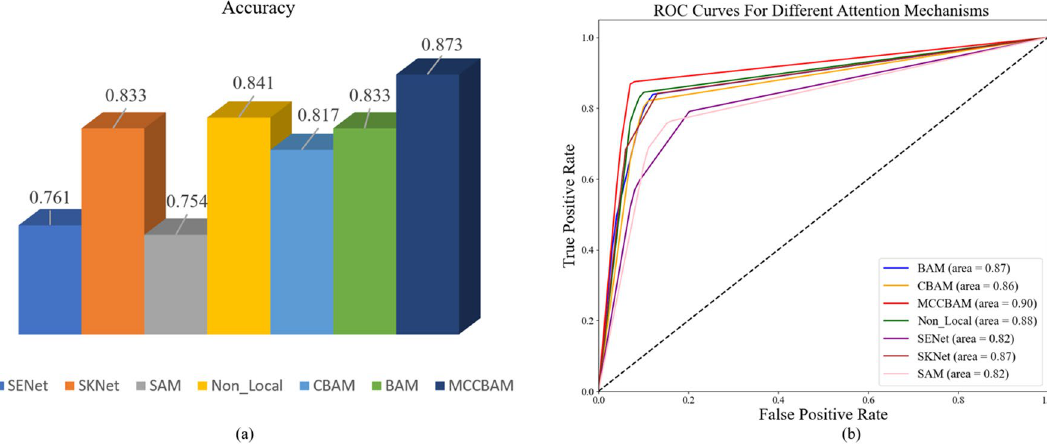
Figure 5. ( a ) Accuracy of VGG16 based on different attention mechanisms. ( b ) AUC values of VGG16 based on different attention